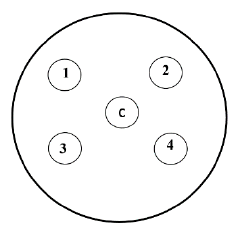
Figure 1. Scheme of the agar well diffusion method: C—control (physiological solution); 1—pure berries/vegetables (B/V) pomace; 2—with Lactobacillus plantarum LUHS135 fermented beverages + B/V; 3—with Lactobacillus plantarum LUHS122 fermented beverages + B/V; 3—with Lactobacillus faraginis LUHS206 fermented beverages + B/V.